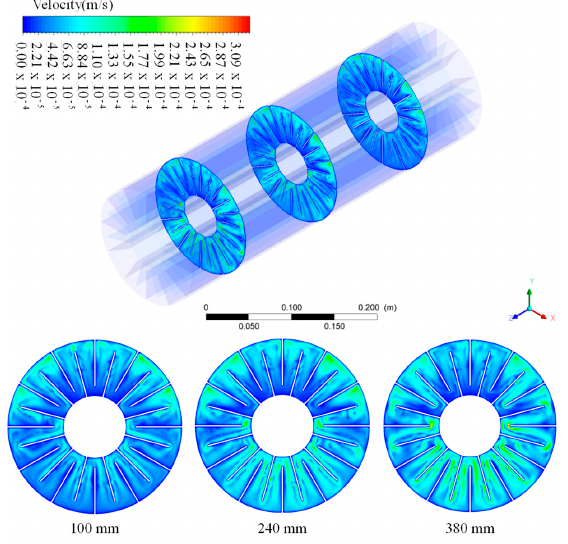
Figure 24. Distribution of velocities in the PCM domain for 50% (t = 6522 s) of its volume in a liquid state.